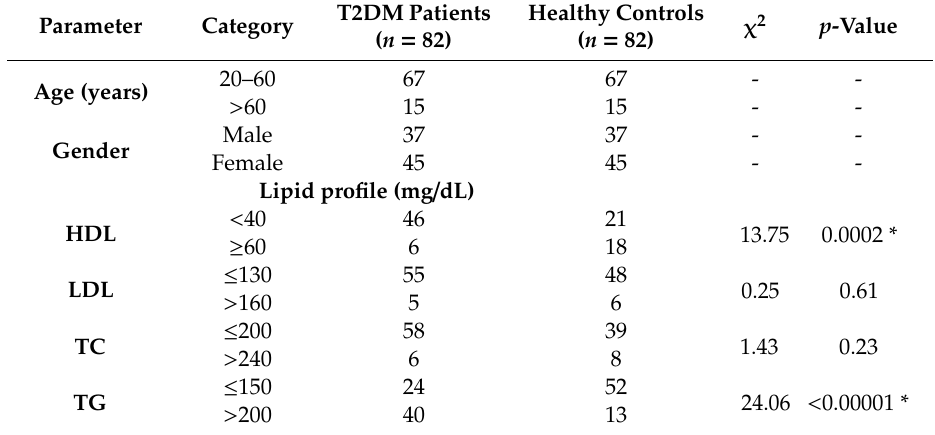
Table 1. Demographic and clinical characteristics of the study population.